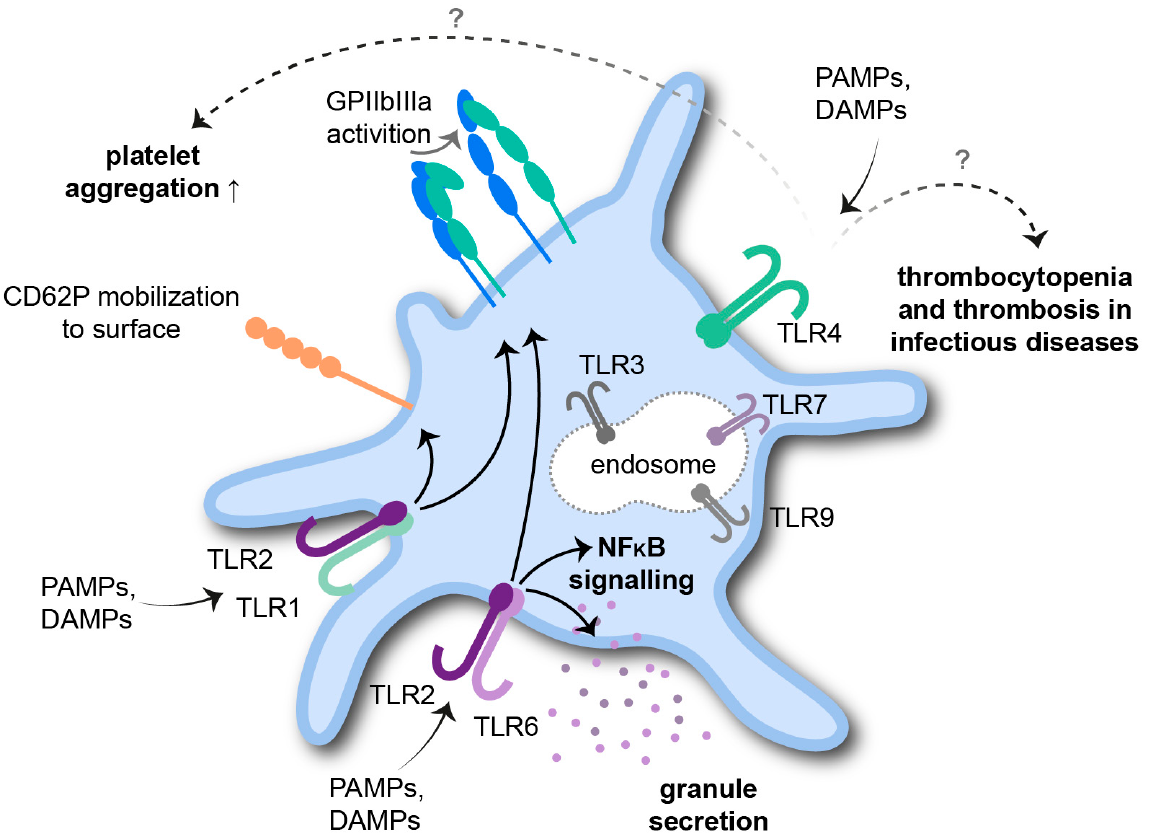
Figure 1. Platelet Toll-like receptors (TLRs). Platelets present functional TLR1, TLR2, TLR3, TLR4, TLR6, TLR7 and TLR9 for the recognition of invading pathogens and endogenous danger signals. Activation via pathogen-associated molecular patterns (PAMPs) and danger-associated molecular patterns (DAMPs) triggers downstream signaling pathways in platelets essential for an adequate immune response.